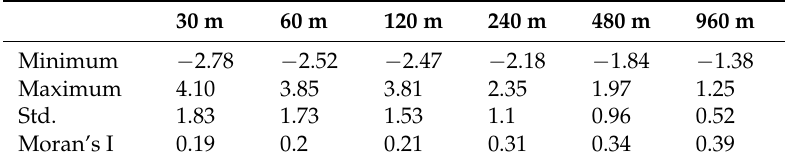
Table 3. The residuals statistical of the GWR models at different spatial